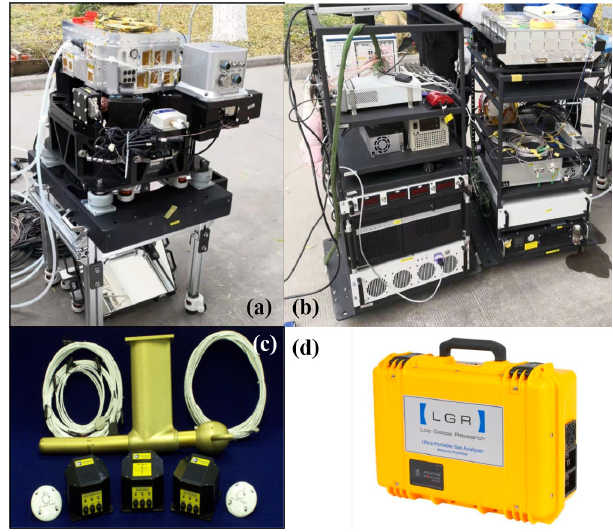
Figure 1. Photos of the IPDA lidar system. (a) This is the transceiver system, installed in the pod outside the aircraft. (b) This is the control system and data acquisition system for some equip- ment, which is installed in the sealed cabin of the aircraft. (c) This is the Aircraft Integrated Meteorological Measurement Sys- tem (AIMMS). (d) This is a commercial instrument called the ul- traportable greenhouse gas analyser, which was installed in an un- sealed cabin of the aircraft.